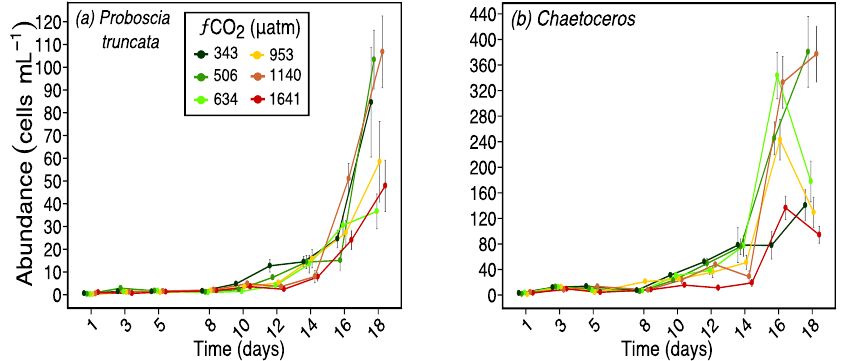
Figure 6. Abundances of (a) Proboscia truncata (pervalvar length ≈ 130µm), and (b) Chaetoceros spp. (pervalvar length ≈ 10µm) over days 1 to 18 of the incubation of a natural protistan community in tanks maintained at different f CO 2 levels. Error bars are standard errors derived from pseudo-replicates undertaken at each time point for each treatment.